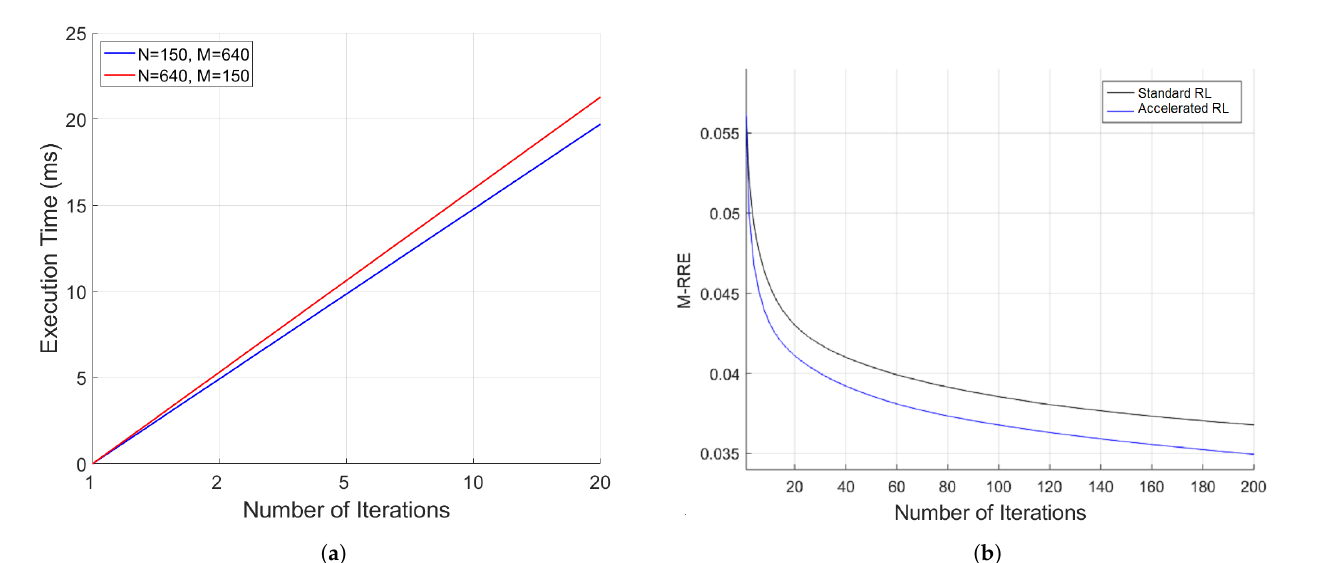
Figure 21. Estimated execution time as a function of number of iterations ( a ) and M-RRE as a function of number of iterations ( b ). Table 5. Comparison between several RL deconvolution implementations.